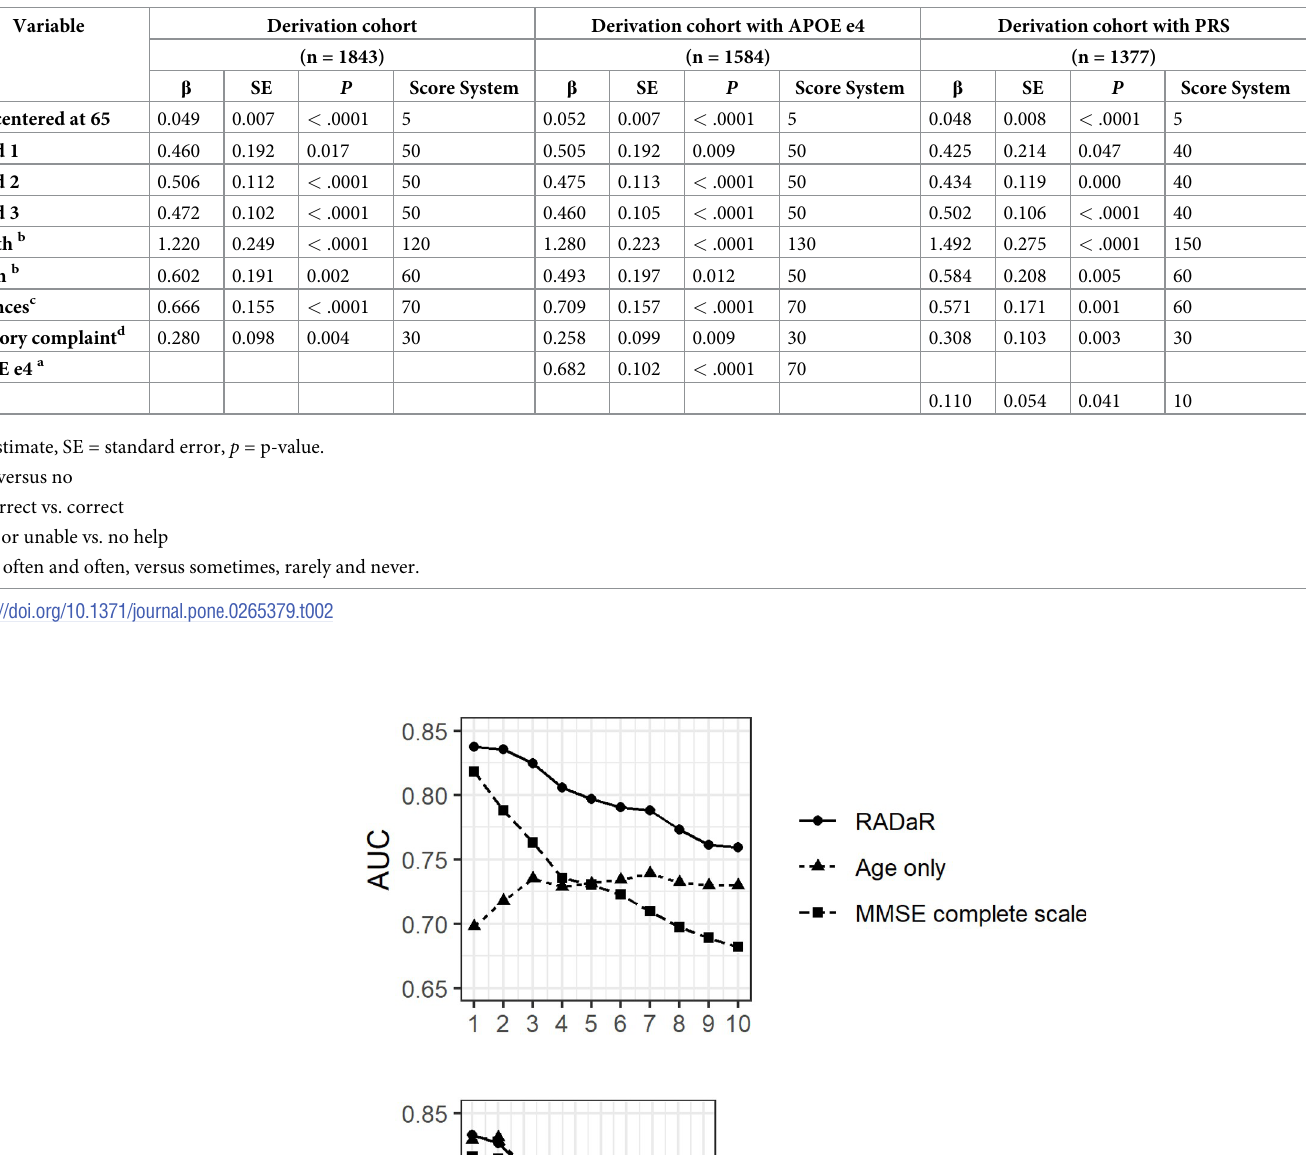
Table 2. Fine-Gray sub-distribution hazard regression model for the cumulative incidence of dementia with death as a competing risk with terms for selected pre- dictors and scoring system based on β estimates. Variable